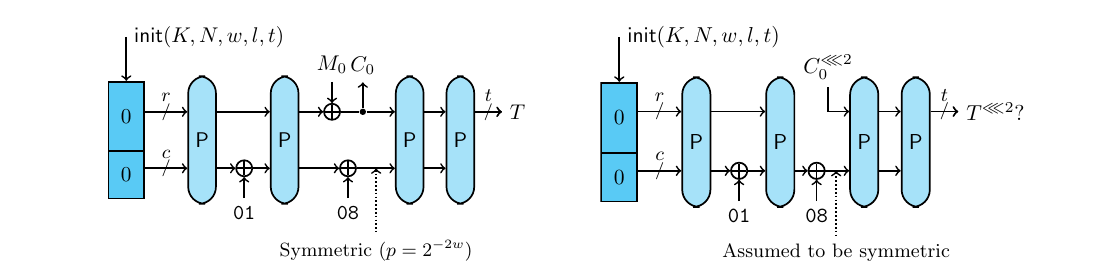
Figure 4: Forgery first step: assume the capacity is symmetric (probability 2 − 2 w ).